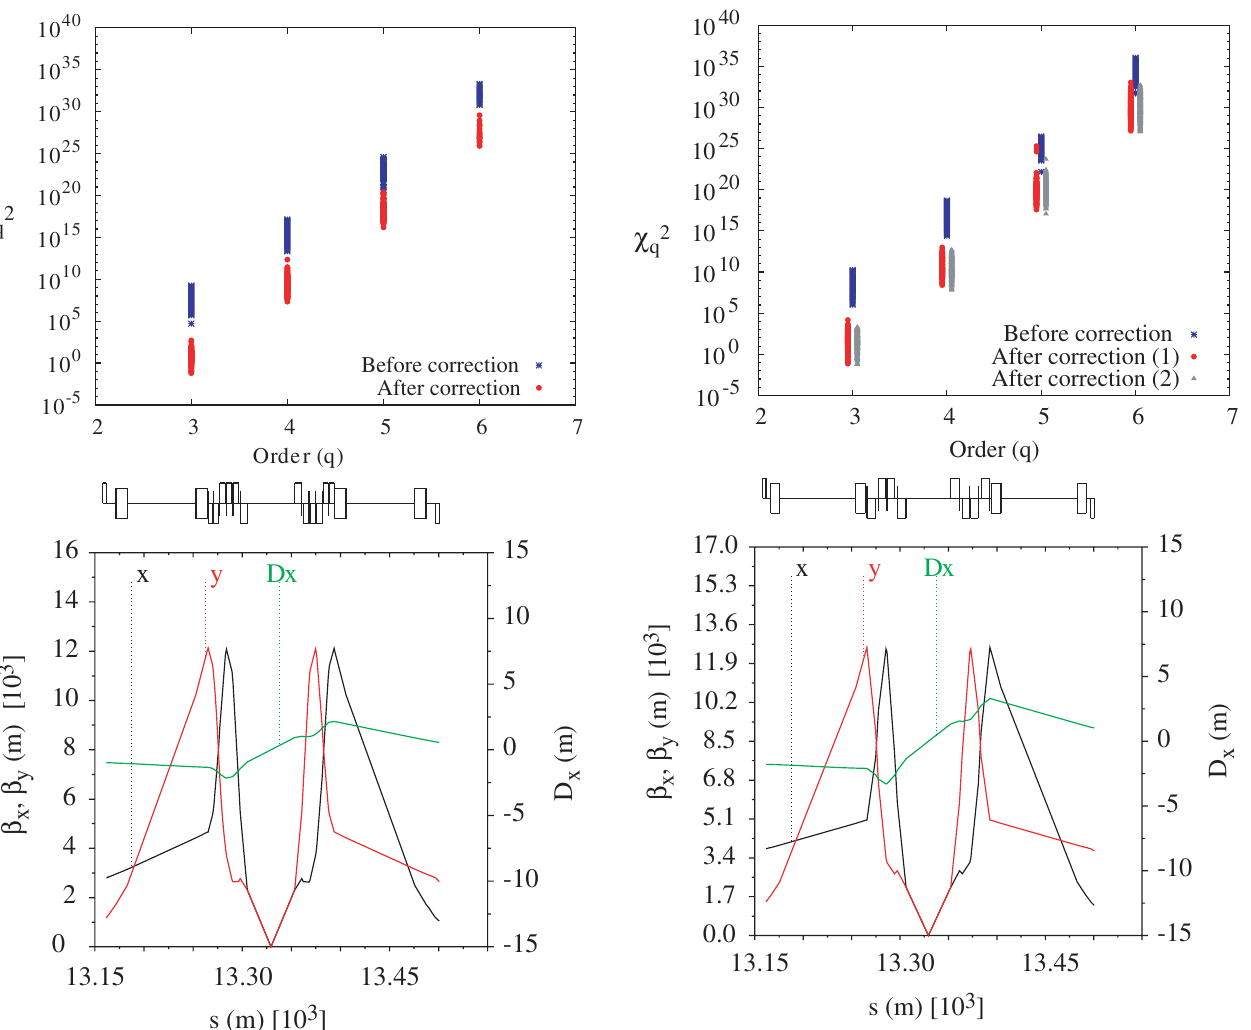
FIG. 2. (Color) Evaluation of the various orders of (cid:2) 2 q (upper plot) before (blue markers) and after (gray and red markers) correction. The red markers represent a nonoptimized (in terms of correctors location) compensation scheme. Sixty realizations of the random magnetic errors are used. The layout is the symmetric one, whose optical functions are also reported (lower plot).